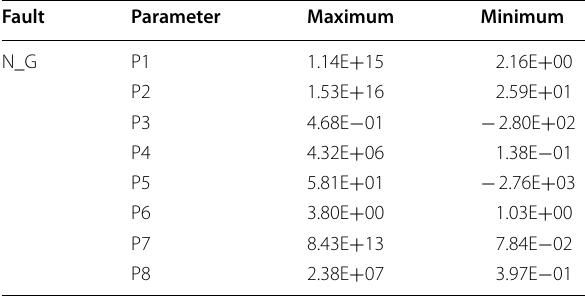
Table 2 NG short circuit fault